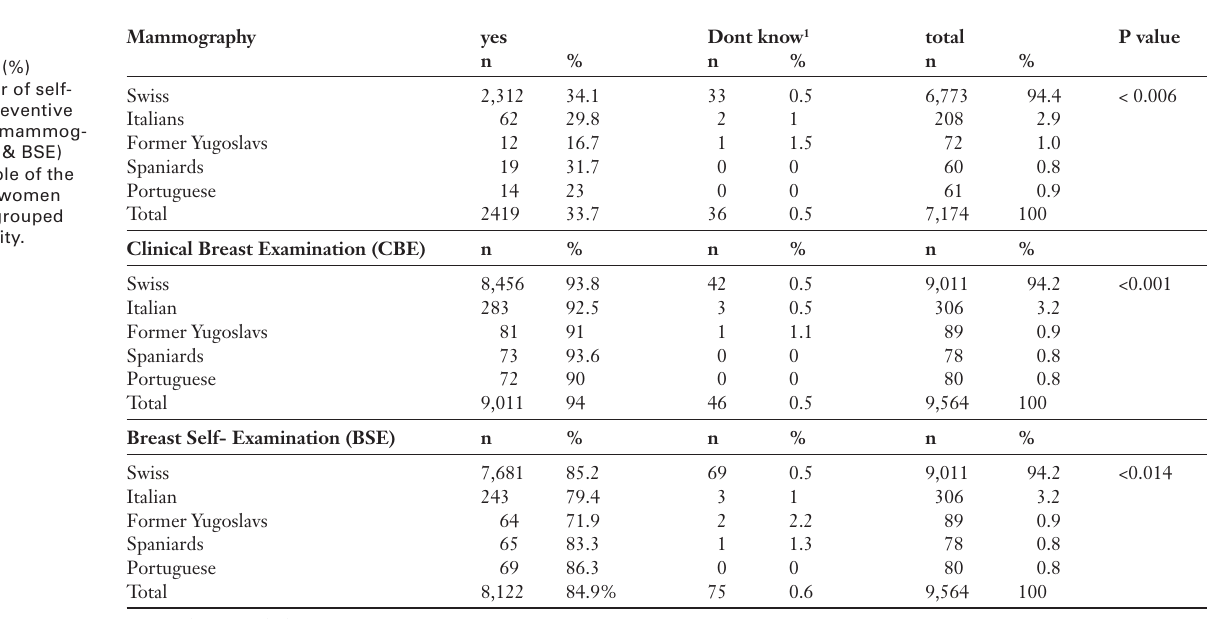
Prevalence (%) and number of self- reported preventive measures (mammog- raphy, CBE & BSE) of subsample of the 2002 SHS, women aged ≥20, grouped by nationality.